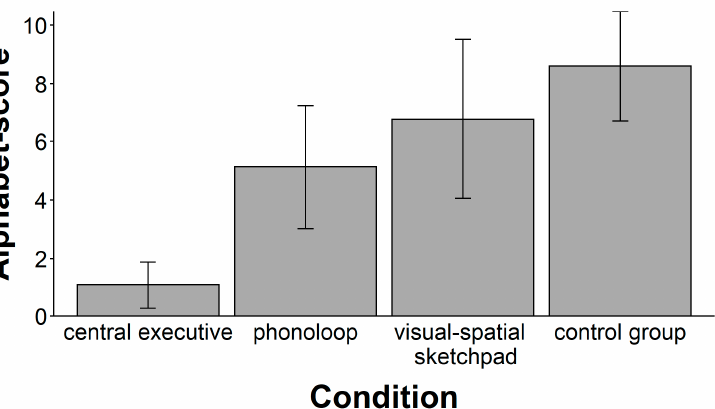
Figure 2. Mean performance in the alphabet task in the four different groups. Whiskers indicate 95% confidence intervals.